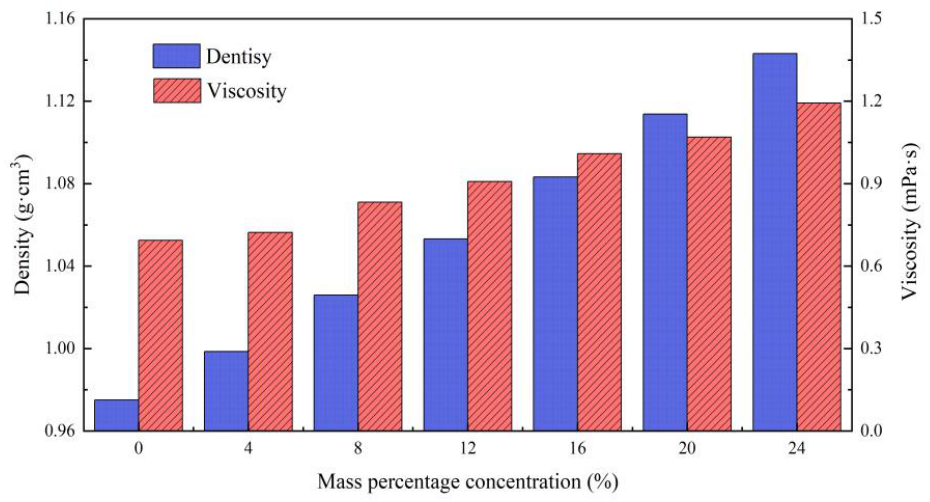
Figure 5. Density and viscosity of brine as a function of salt mass fraction at 55 °C .